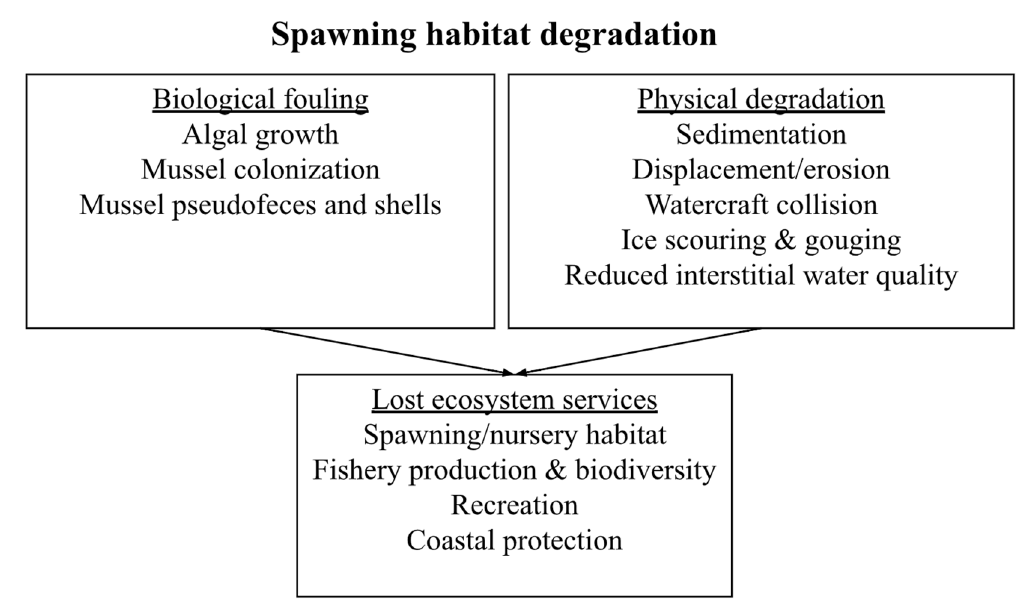
Figure 1. Conceptual diagram of the causes and effects of rocky fish spawning habitat degradation.